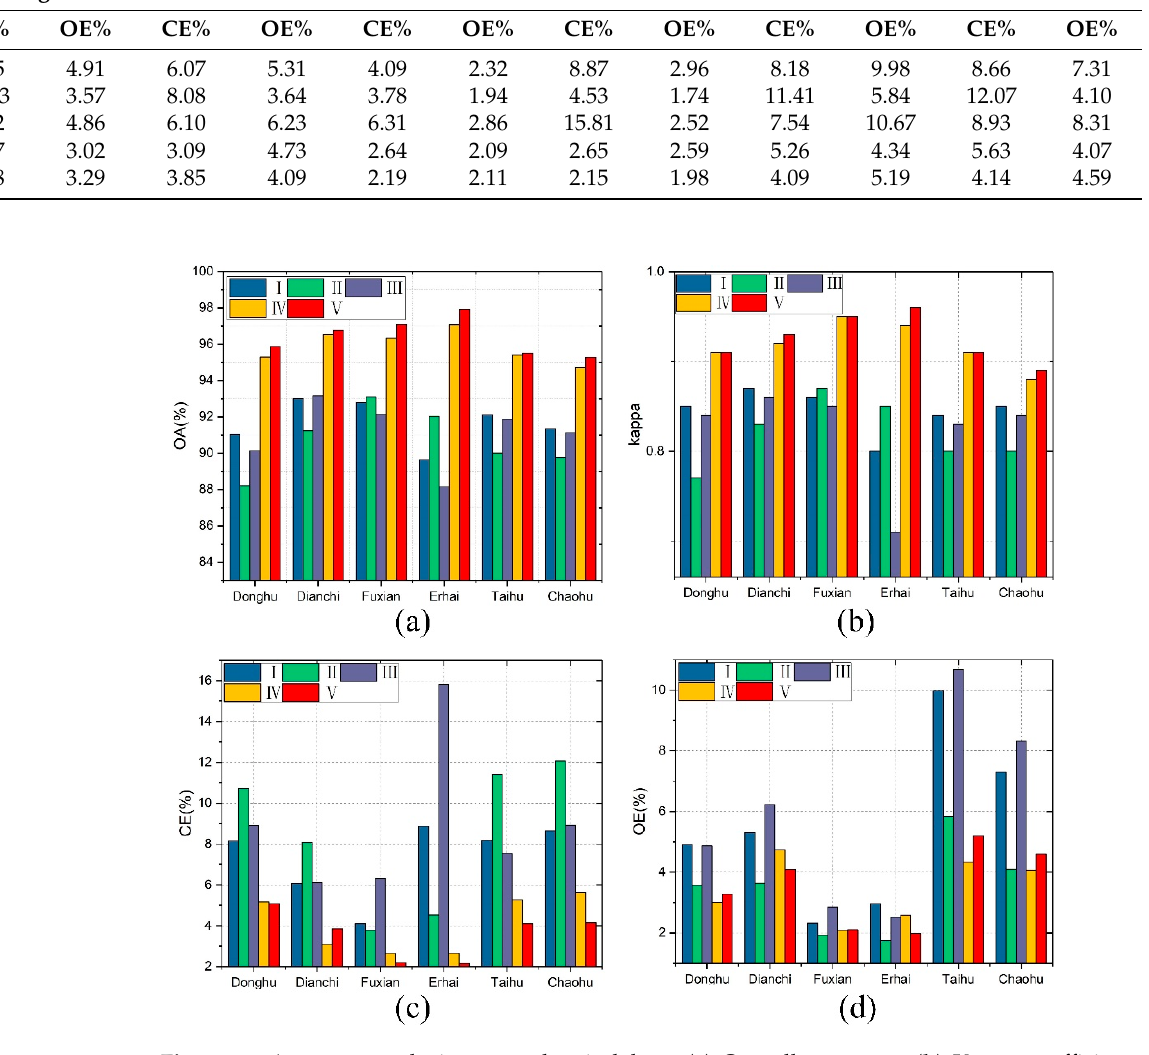
Figure 9. Accuracy analysis across the six lakes. ( a ) Overall accuracy. ( b ) Kappa coefficients. ( c ) Commission error. ( d ) Omission error.